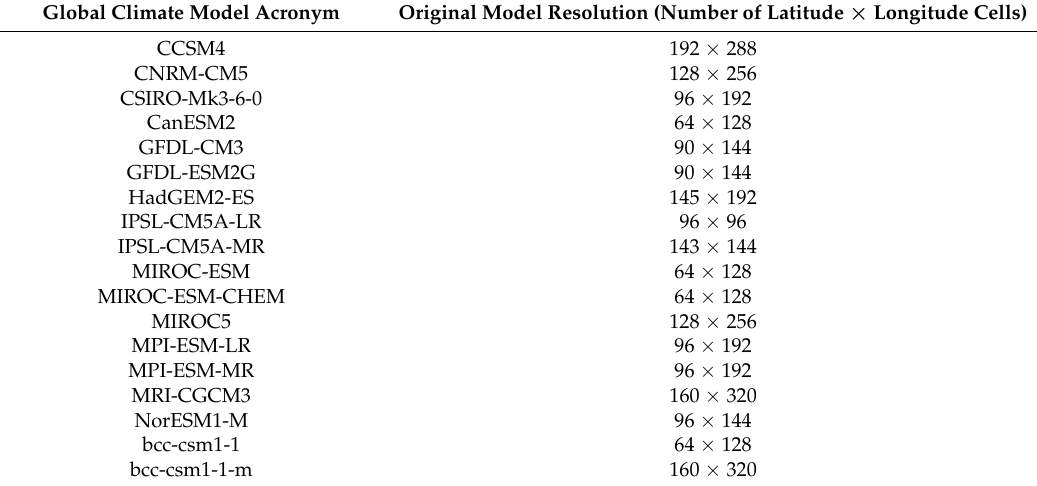
Table 2. Grid resolution of 18 global climate models used in